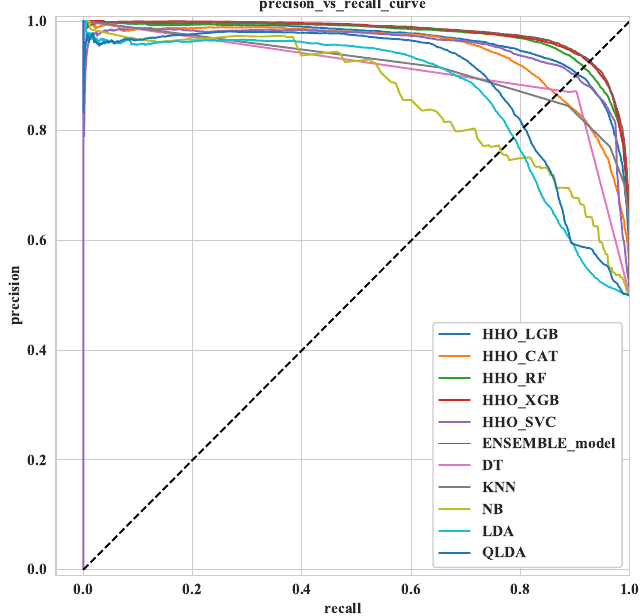
Figure 3. Precision vs. recall curve.